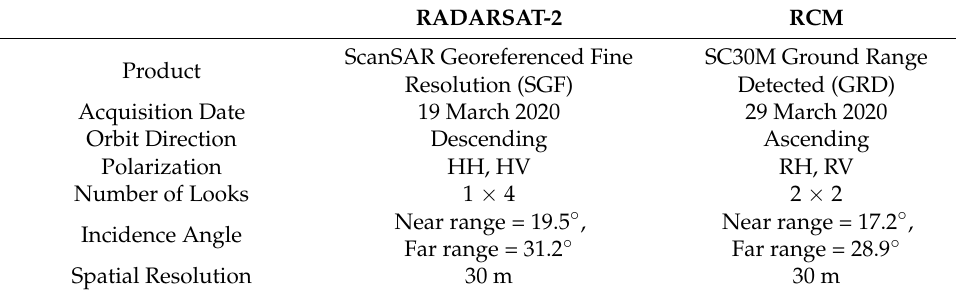
Table 3. Metadata of the RADARSAT-2 and RCM Acquisitions.